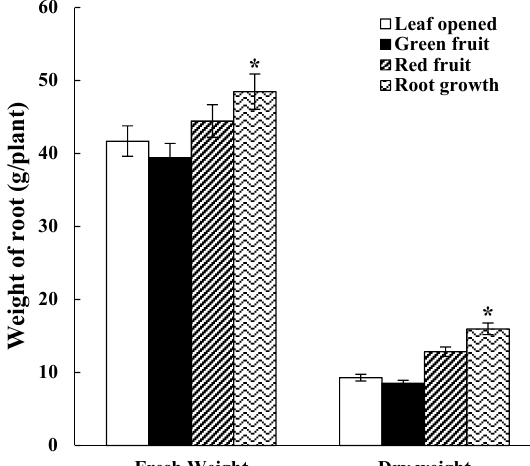
Figure 1. Fresh and dry weights of ginseng roots at different growth stages. The data are expressed as the mean ± SD. * indicated that the different growth stages are significantly different at the 0.05 level.